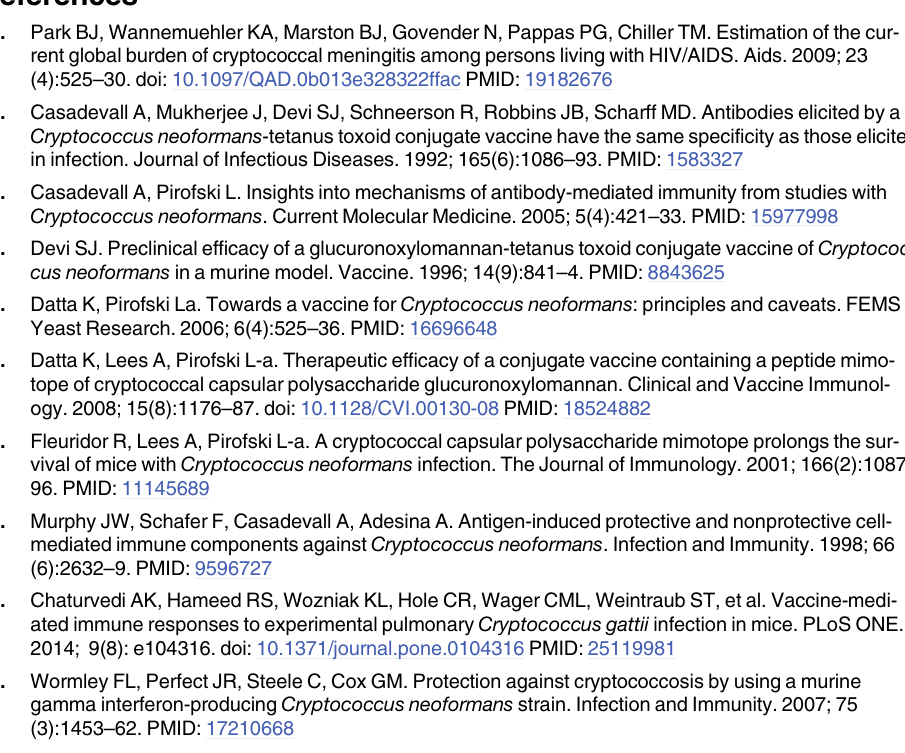
S3 Table. Total leukocyte counts in the blood of treated and untreated mice with or without C . neoformans infection. Studies were performed on CBA/J mice (three mice per group), GlcCer was administered daily by intraperitoneal injection 20 μ g/day for 90 days prior to analy- sis.